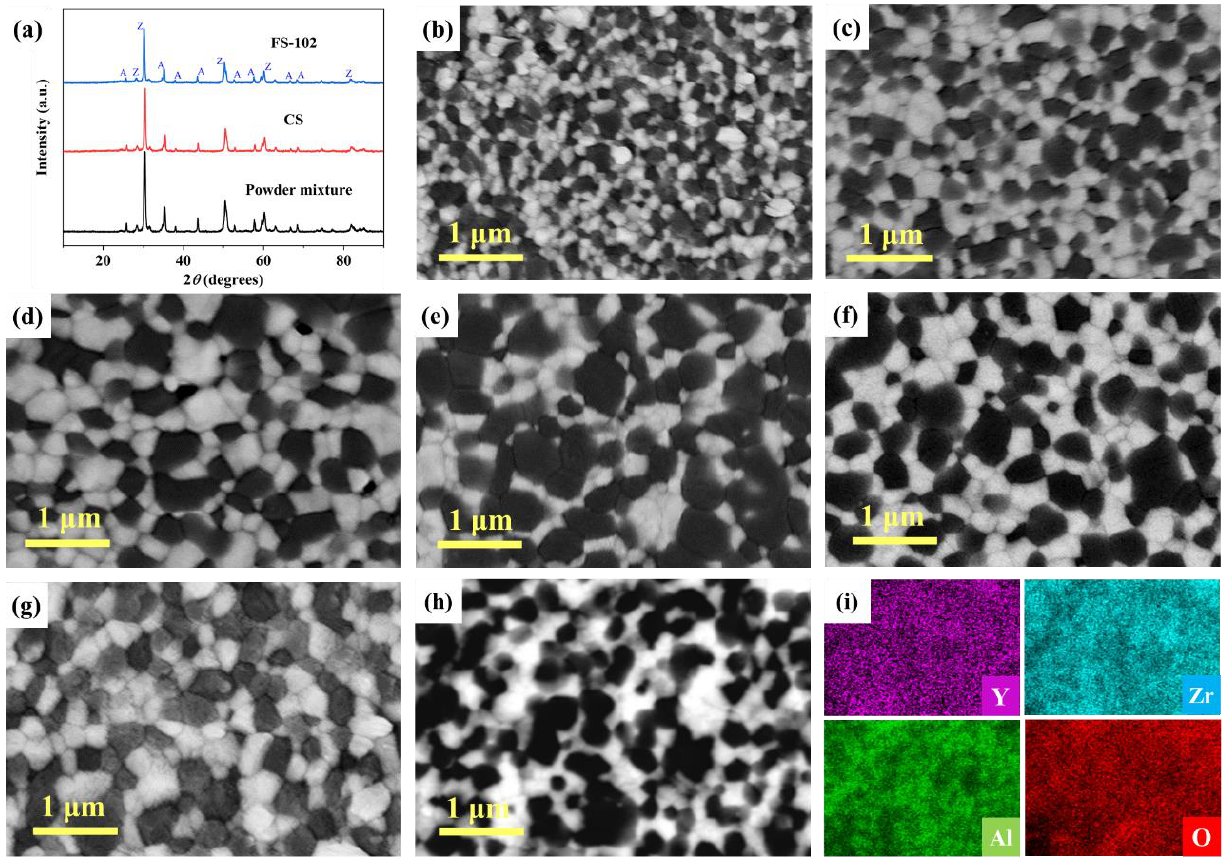
Figure 3. ( a ) XRD patterns of FS-102, conventional sintered sample (CS) and starting powder mixture. SEM images of 3YSZ/Al 2 O 3 composites flash-sintered at the different current densities ( b ) FS-51, ( c ) FS-64, ( d ) FS-76, ( e ) FS-89 and ( f ) FS-102 and of the ( g ) conventional sintered 3YSZ/Al 2 O 3 composite. ( h ) SEM image and ( i ) EDS maps of FS-102.